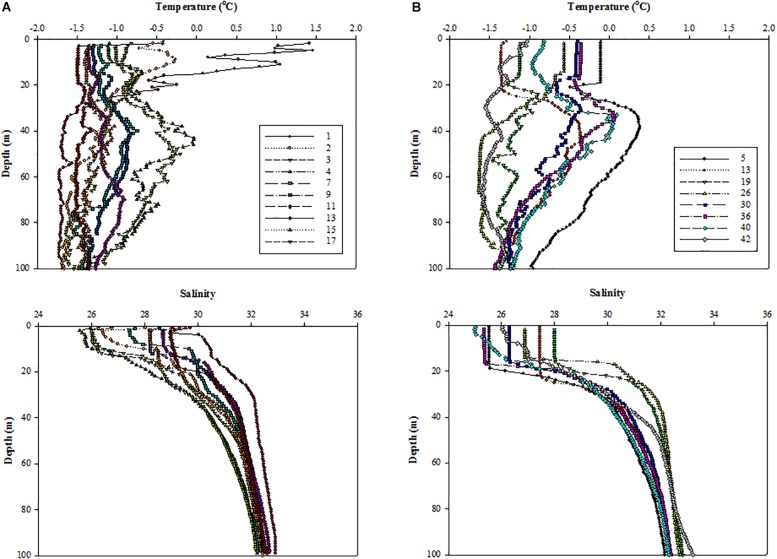
Vertical structures of temperature (upper panel) and salinity (lower panel) at all the experimental stations in the northern Chukchi Sea in (A) 2011 and (B) 2012.